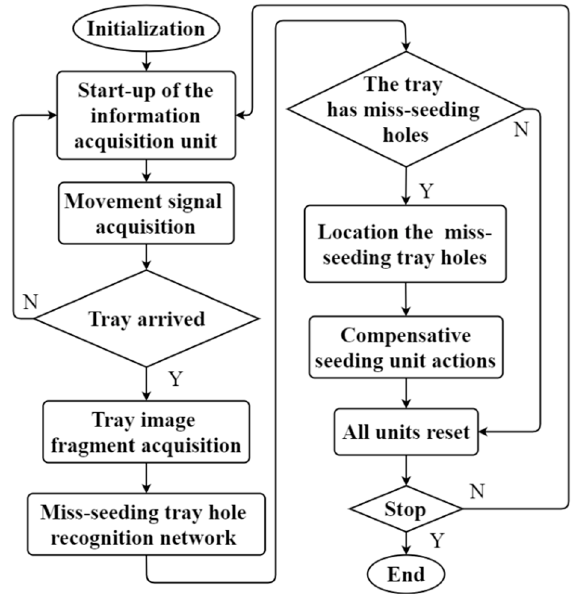
Figure 7. Software system flowchart.